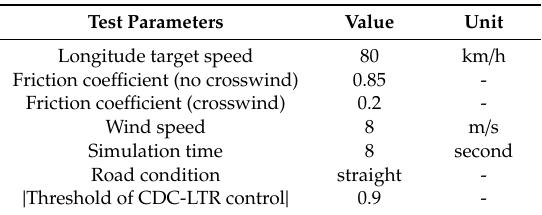
Table 5. Main parameters of crosswind test.